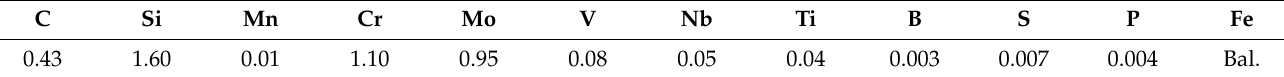
Table 2. Chemical composition of the experimental steel (weight percentage).